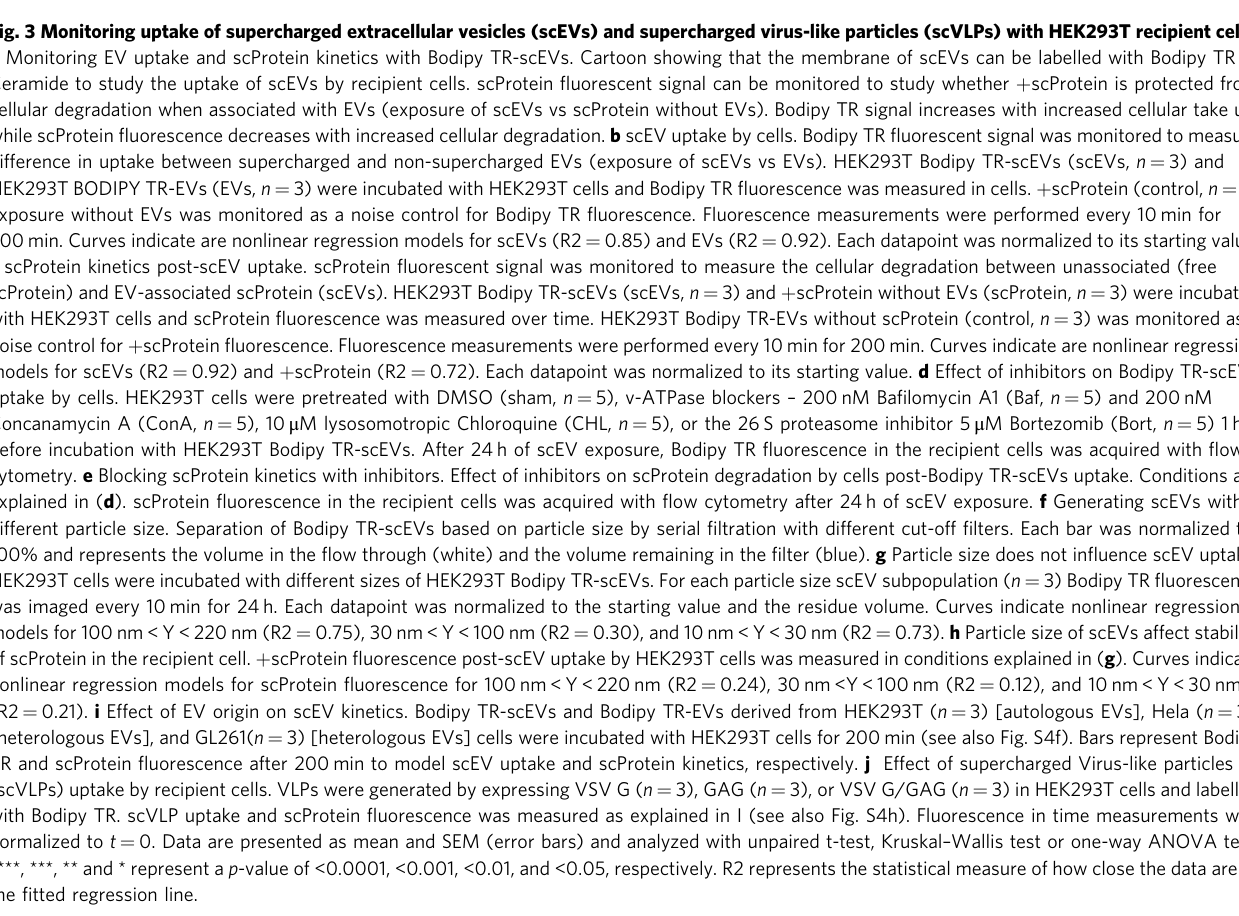
Fig. 3 Monitoring uptake of supercharged extracellular vesicles (scEVs) and supercharged virus-like particles (scVLPs) with HEK293T recipient